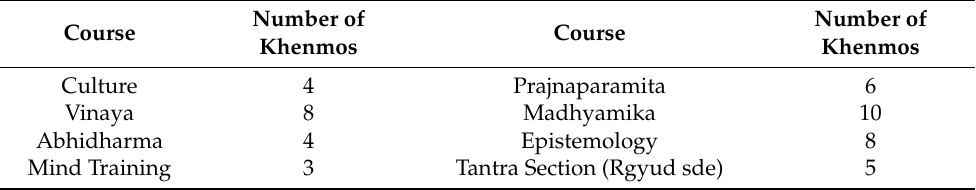
Table 4. The numbers of Khenmos who taught the main formal courses in